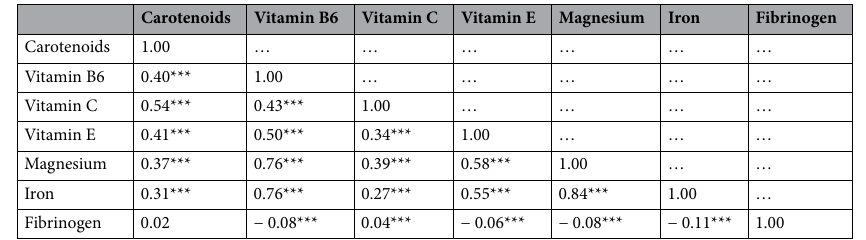
Table 2. Spearman correlation coefficients among the micronutrients intake and fibrinogen. *p ≤ 0.05, **p < 0.01, ***p <